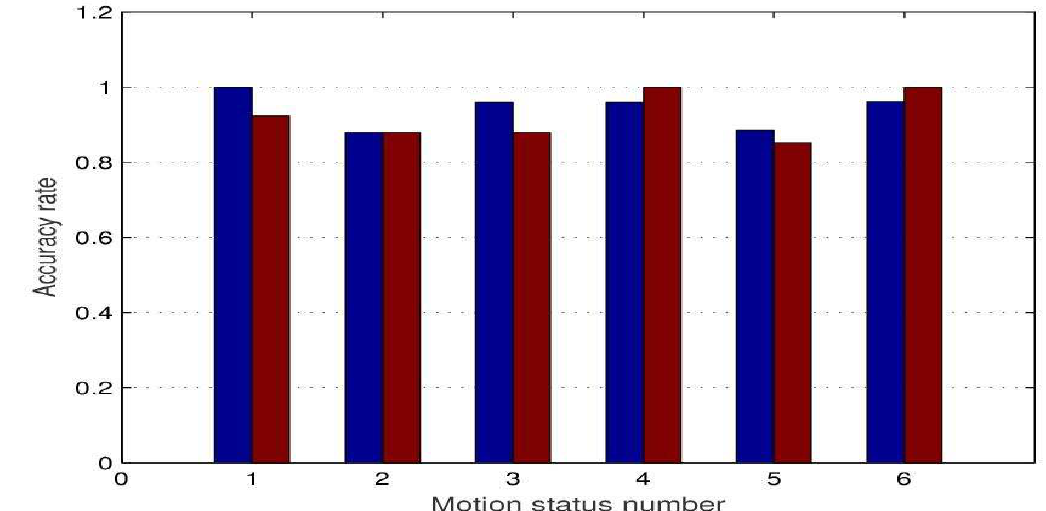
Figure 11. Comparison of indoor(blue) recognition accuracy and corridor(red) recognition